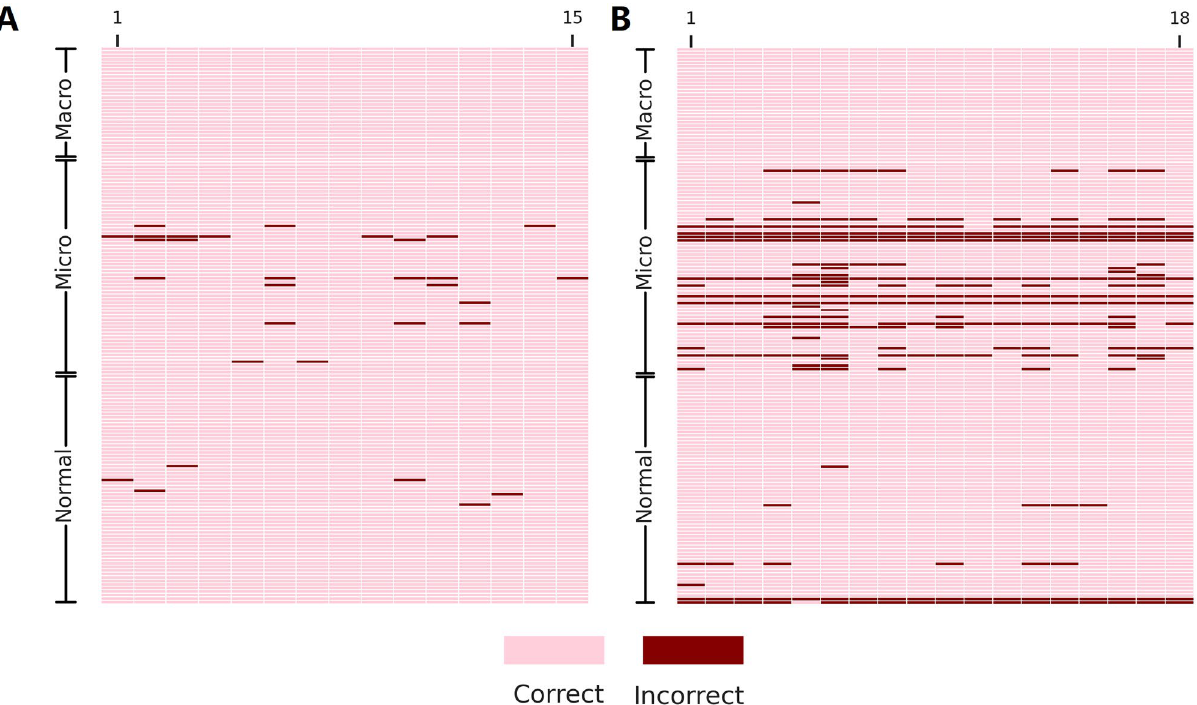
Figure 3. Per-WSI diagnosis for 15 pathology experts ( A ) and 18 patch-DNN models ( (B ). The systematic prediction errors for normal WSIs (> 4) and micrometastasis WSIs (> 6) can clearly be observed in comparison to the experts’ diagnosis. The order of the 18 patch-DNN models is as follows: InceptionV3-1-1:3, InceptionV3-1-1:5, InceptionV3-1-1:7, ResNet101-1-1:3, ResNet101-1-1:5, ResNet101-1-1:7, Xception-1-1:3, Xception-1-1:5, Xception-1-1:7, InceptionV3-2–1:3, InceptionV3-2-1:5, InceptionV3-2-1:7, ResNet101-2-1:3, ResNet101-2-1:5, ResNet101-2-1:7, Xception-2-1:3, Xception-2-1:5, and Xception-2-1:7. The format of the models is the DNN-repeat-tumor normal patch ratio.